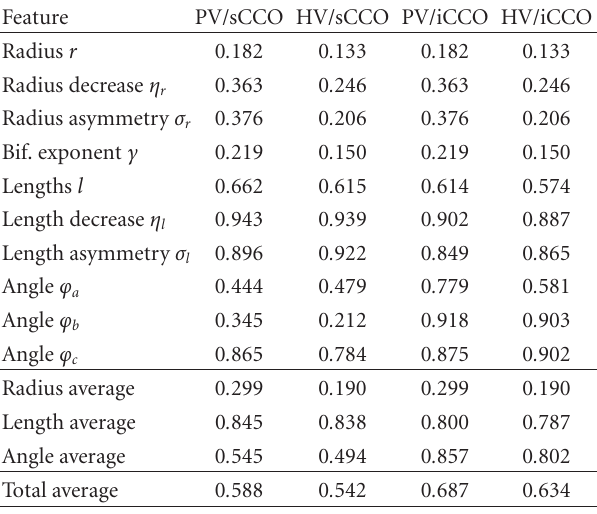
Table 6: In this table we compare the similarity of vascular trees obtained by standard CCO (sCCO) and improved CCO (iCCO) to the clinical CT data sets. The similarity values for individual features, but not the averages, can be compared to the HV and PV single-population similarities in Table 3.